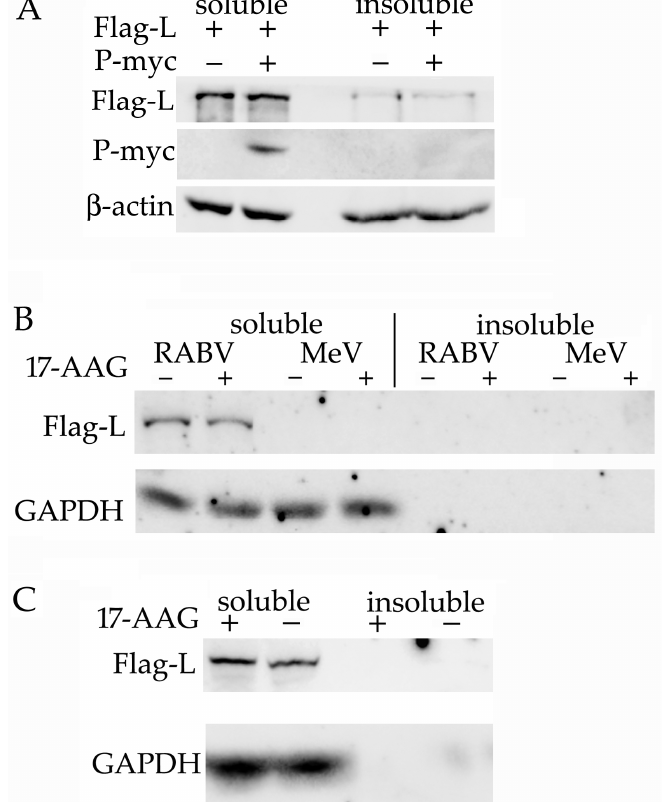
Figure 3. Soluble RABV L protein is expressed without P protein present. ( A ) HEK293 cells were transfected with plasmids that expressed the RABV Flag-L and P-myc proteins, as indicated. The cells were lysed with IP buffer 48 h after transfection. The insoluble fraction was separated by centrifugation and solubilized with 8 M of urea. Proteins were detected with antibodies specific for Flag and myc. HEK293 cells were transfected with plasmids that expressed the Flag-L proteins of the RABV and MeV virus ( B ) or with the plasmid that expressed VSV Flag-L ( C ). We added 0.5 μ M 17-AAG 8 h after transfection. Cells were lysed 48 h after transfection. The results of one of two experiments are presented.